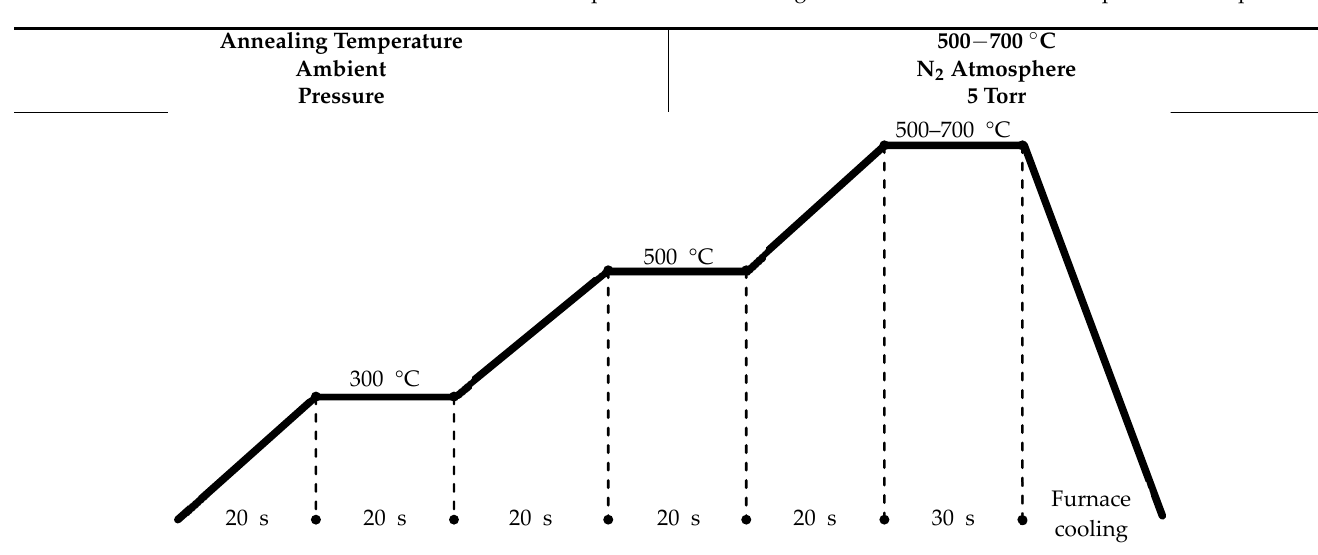
Table 2. Conditions for rapid thermal annealing of HZO thin films after TiN top electrode